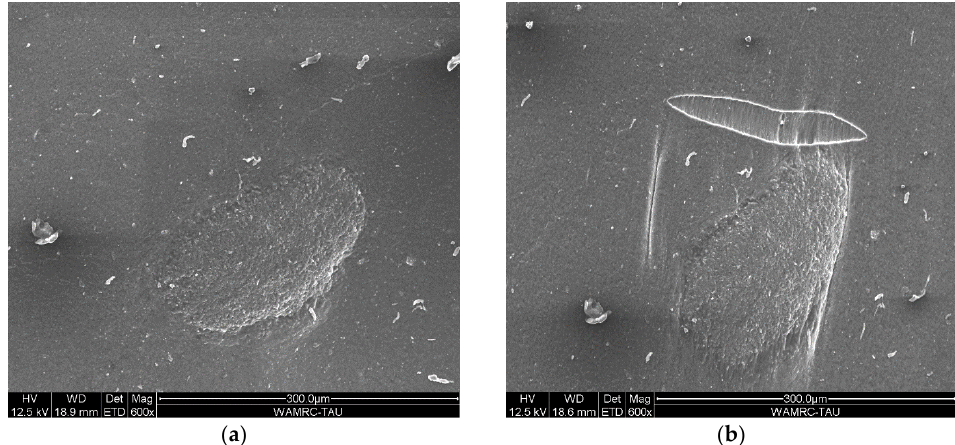
Figure 6. 10 wt.% MWCNT/VMQ composite under tension in SEM. ( a ) an agglomerate before elongation. ( b ) the same agglomerate at 100% strain along the vertical axis of the image. Polymers 2020 , 12 , x FOR PEER REVIEW Under compression, CNTs exhibit a clear advantage over CB: State-of-the-art 10 wt.% CB/VMQ